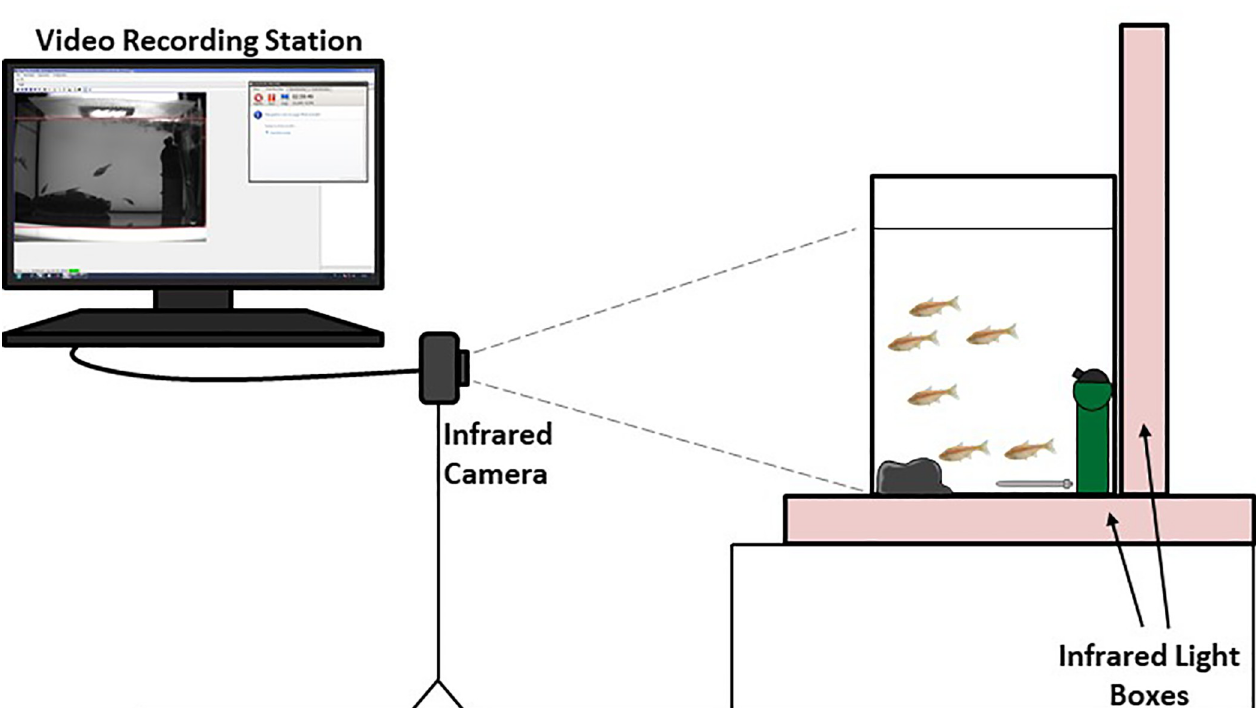
Fig 1. Recording setup. Infrared light boxes were placed at the back and bottom of a tank containing 6 fish, an oxygenating pump (green), a heating resistance (grey) and pouzzolane in a net (black). Recordings were obtained overnight with an infrared camera. Drawing not to scale.